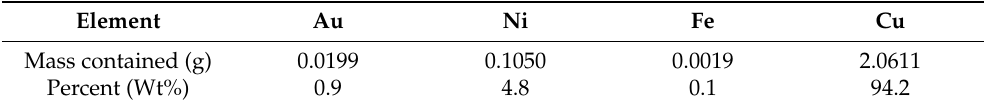
Table 2. Chemical composition by MP-AES analysis of the digestion of 478 pins with aqua regia. Element Au Ni Fe Cu Mass contained